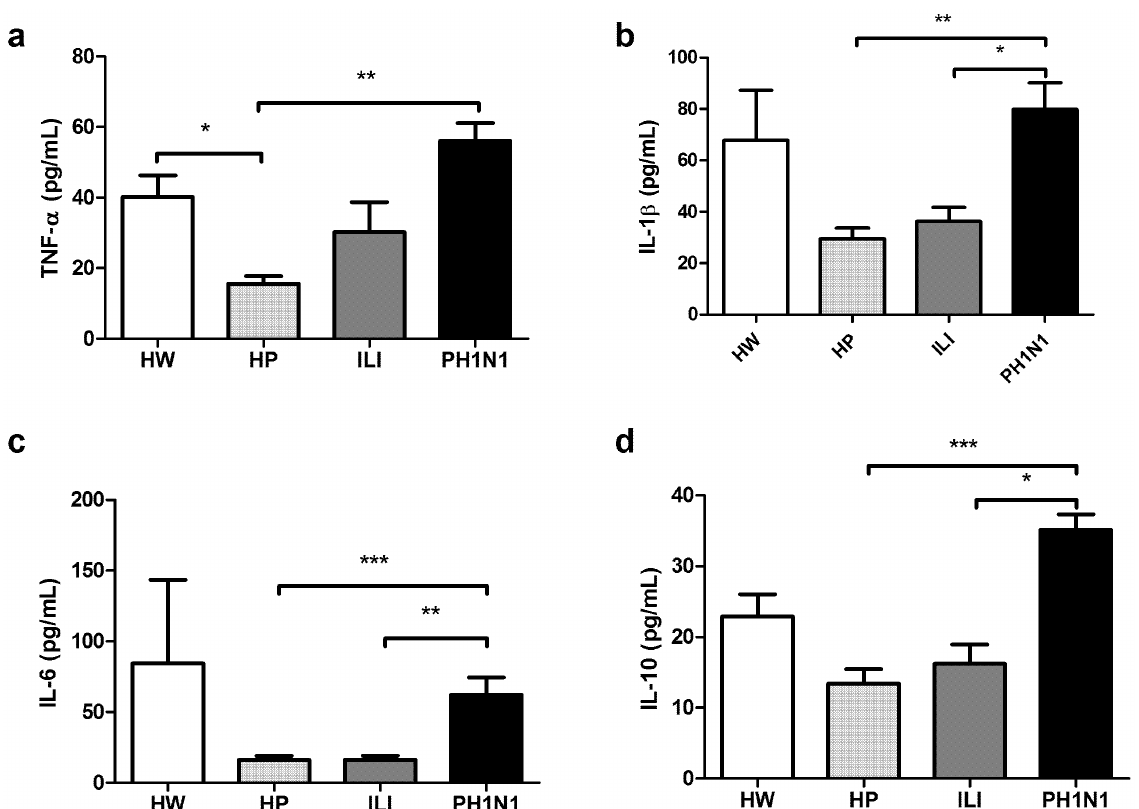
Figure 2. Serum cytokine concentrations in HW, HP, ILI and PH1N1 women. Pro-inflammatory TNF- a (a), IL-1 b (b) and IL-6 (c) and anti- inflammatory IL-10 (d) cytokines were quantified using a CBA system with flow cytometry. The Kruskal-Wallis test with Dunn’s multiple comparison post-test was performed using the GraphPad Software. The significance values were *p , 0.05, **p , 0.01, ***p , 0.001.